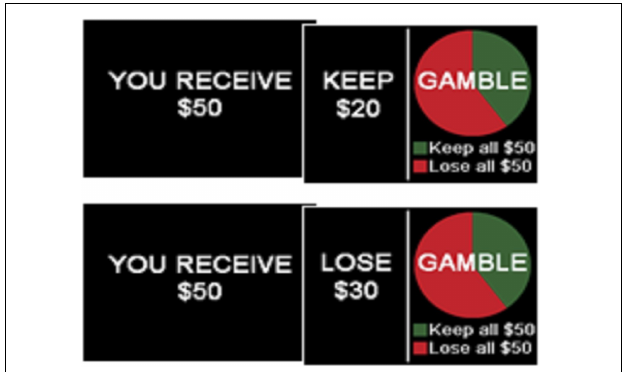
FIGURE 1 | Financial risky-choice framing paradigm. The decision-making task used in this study was adapted from De Martino et al. (2006) by using American dollar amounts instead of representing monetary values in euros. Participants were required to choose between keeping/losing a portion of the initial endowment of each trial or choosing to gamble on the initial endowment to either win or lose the entire amount, with the probability of winning represented by the pie chart on the right. The two options are balanced in that the amount offered in the sure option is the same as the odds represented in the gambling option. The sure choice was either presented as an option to “keep” or “lose” a portion of the initial endowment. All “keep” trials had equal but opposing “lose”